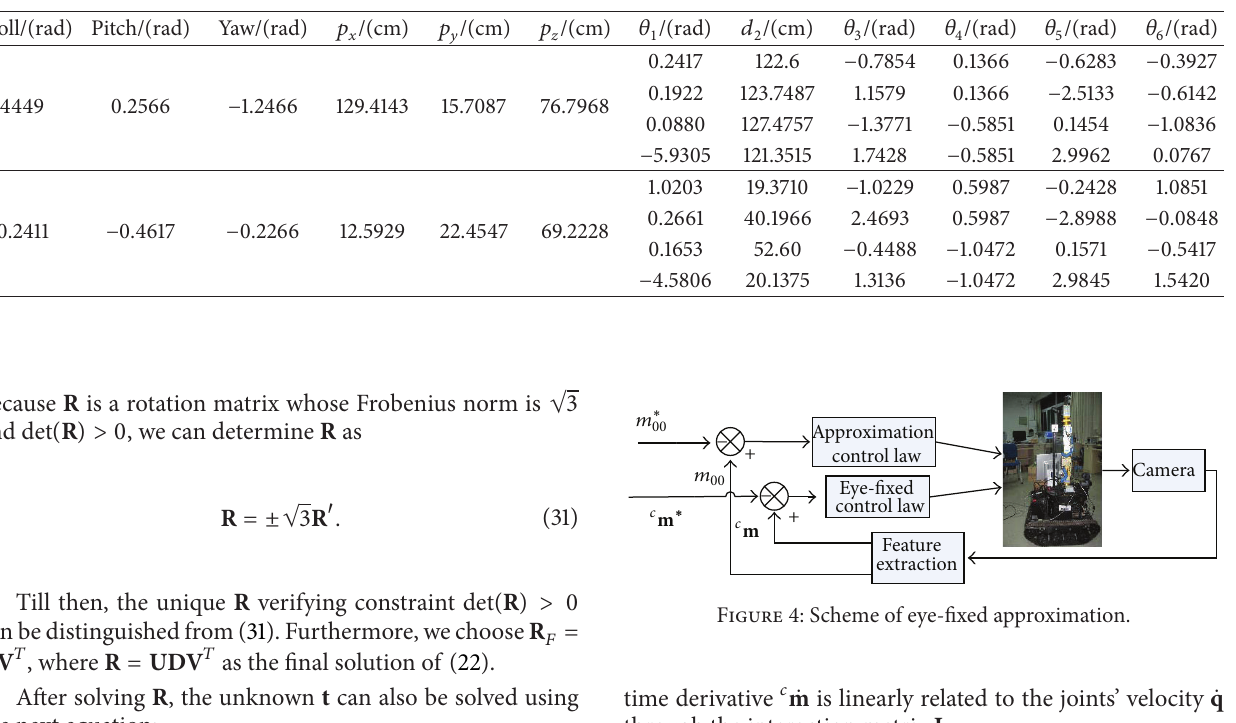
Table 3: Inverse kinematic results of the generalized manipulator.